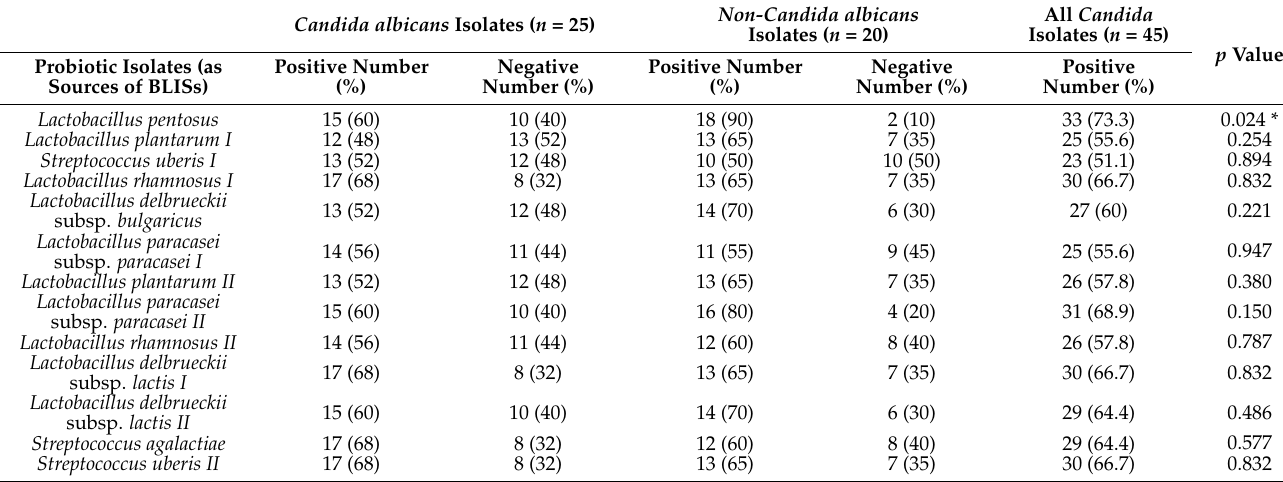
*, indicates statistical